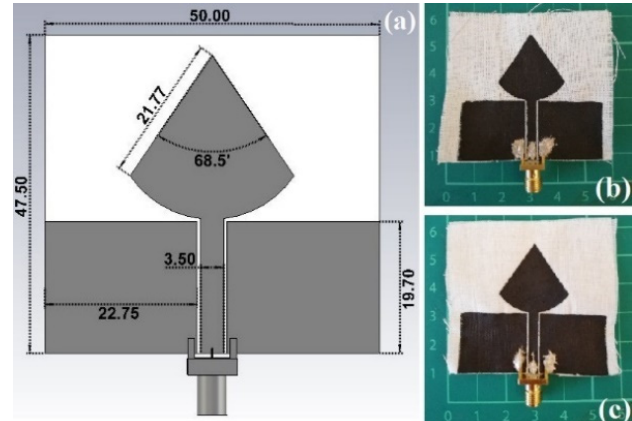
Figure 1. ( a ) PICA antenna design CAD model with the dimensions in mm; Prototyped models: ( b ) CNTs/CNC—1:1; ( c ) CNTs/CNC—1.5:1.5. ( b ) CNTs/CNC—1:1; ( c )